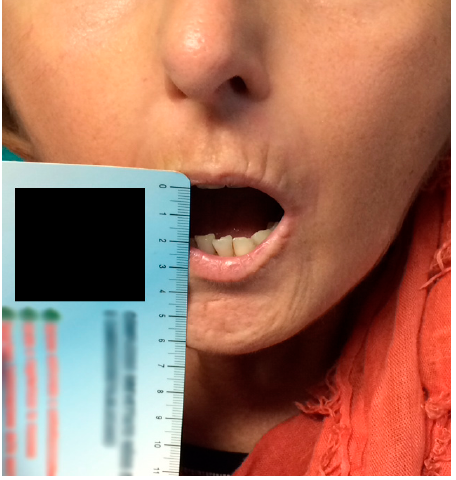
Figure 3. Maximum active opening: 19 mm, negative end-feel. Pronounced labial wrinkles, sharp nose.